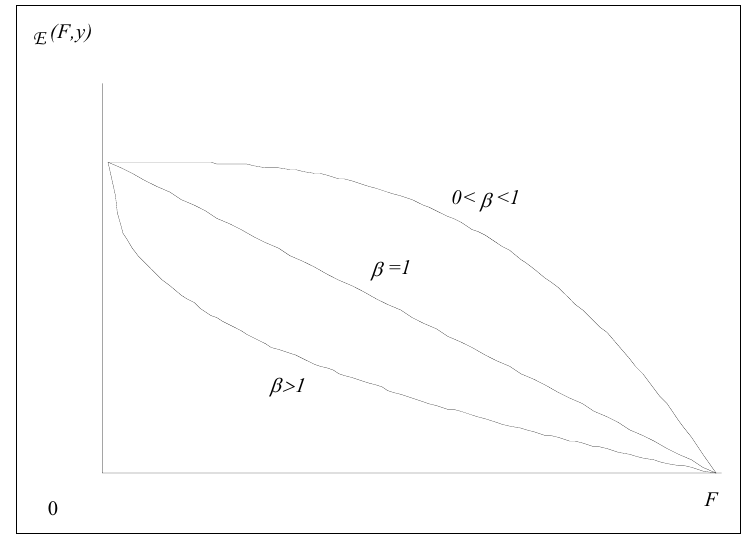
Figure 1 – Income elasticity $ (F,y) of the CDF